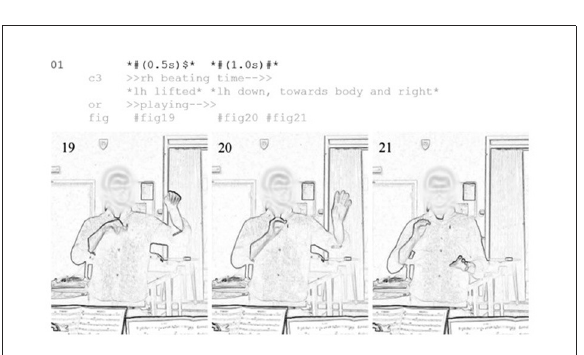
FIGURE5 Example 5 -